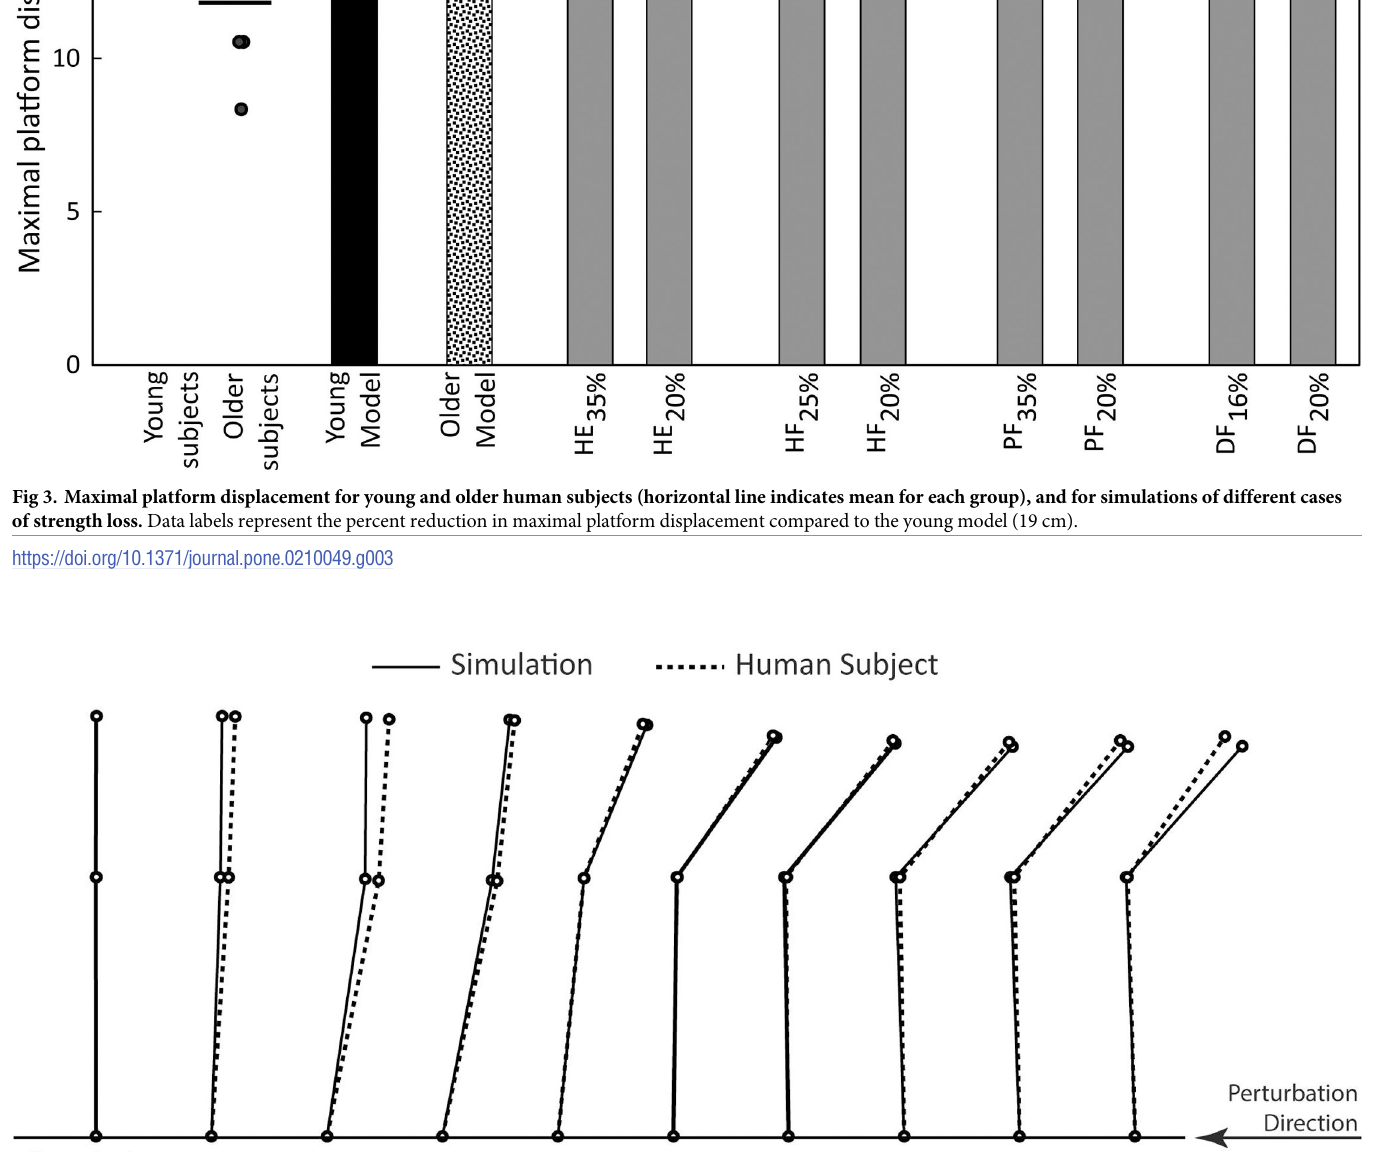
PLOS ONE | https://doi.org/10.1371/journal.pone.0210049 January 18,